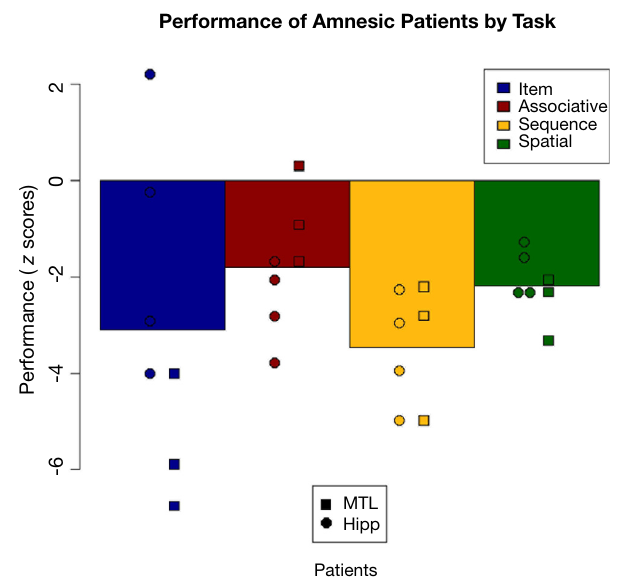
Figure 9 | Performance decrements of the patients on each task, shown as deviation from comparison participants in z -scores. Shown are overall patient group means and individual patient scores with hippocampal patients as circles and MTL patients as